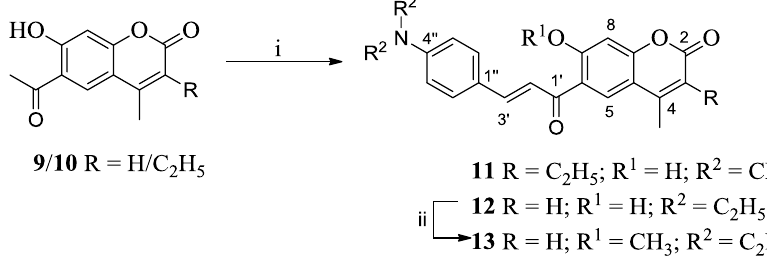
Scheme 2. Synthesis of compounds 11 – 13 . Reagents and conditions : i. 4-dialkylamino-benzaldehyde,